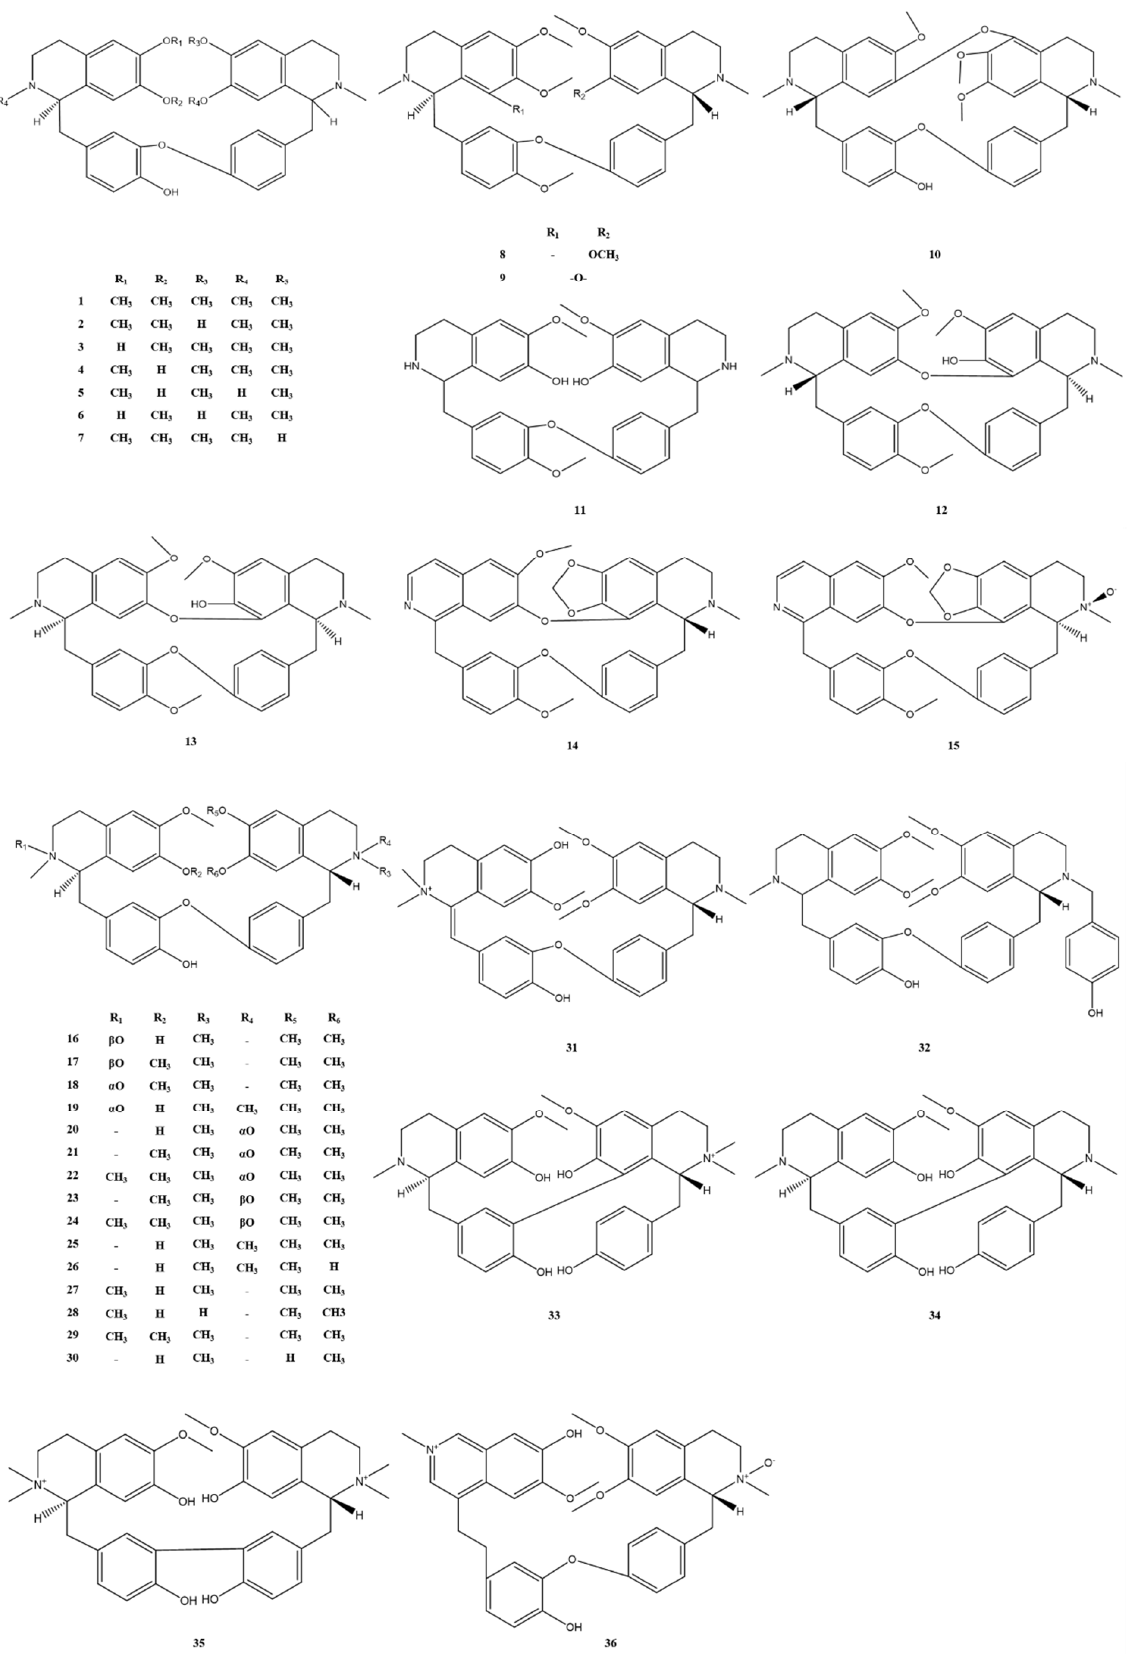
Figure 2. Bisbenzylisoquinoline alkaloids (structural skeleton I) in M. Rhizoma.